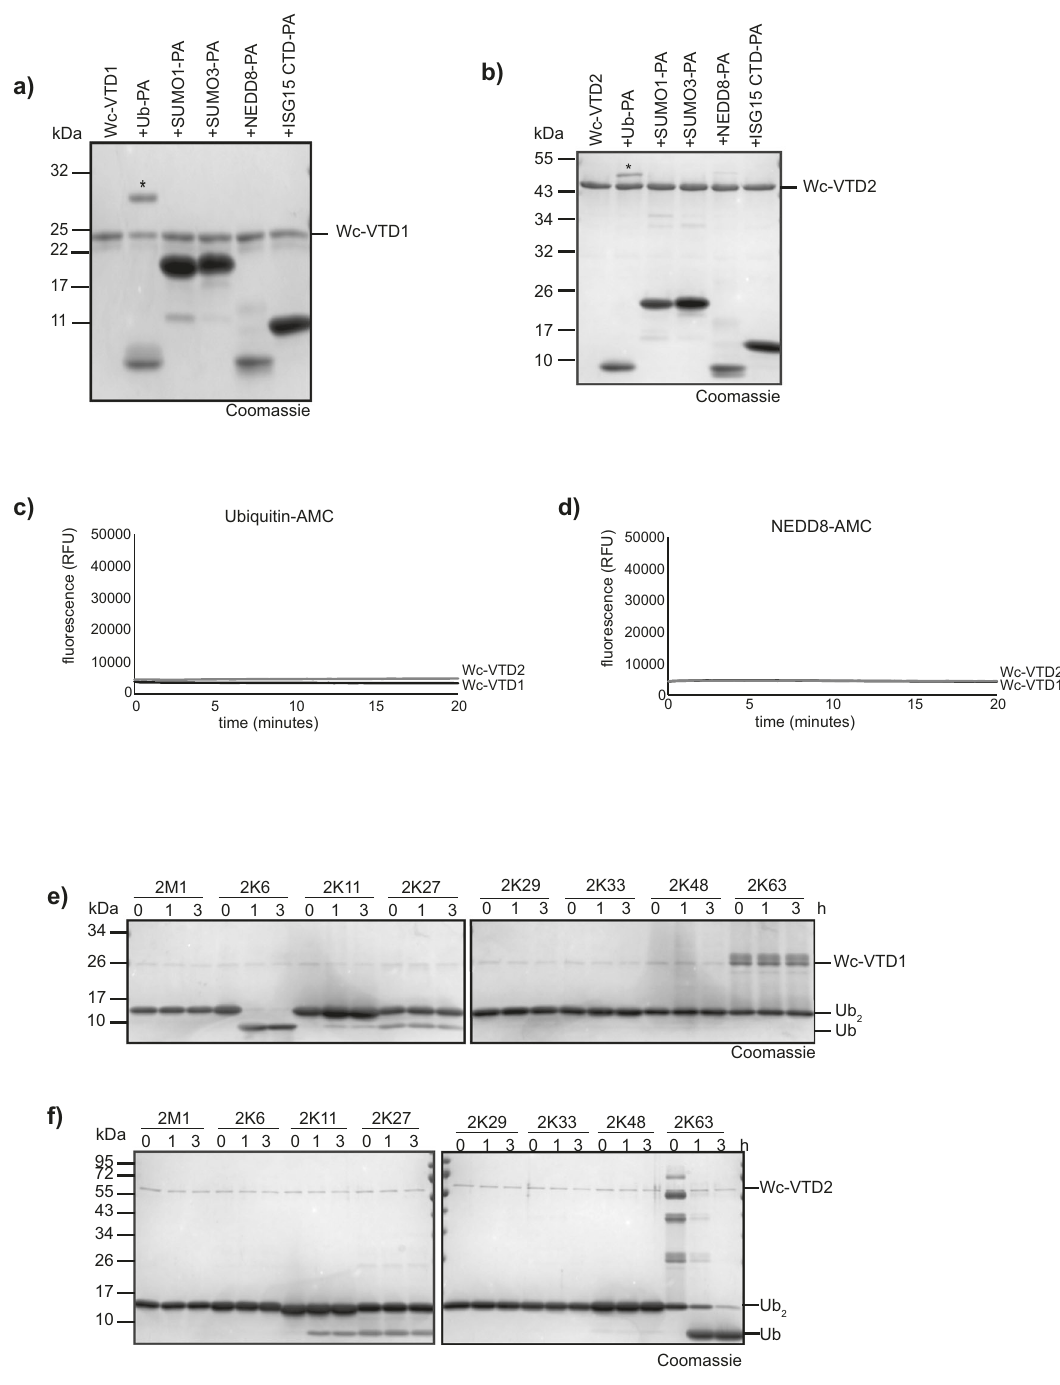
Fig. 4 | Activity of bacterial VTDs. a , b Reaction of Wc-VTD1 ( a ) and Wc-VTD2 ( b ) with Ub and Ubl activity-based probes. Asterisks mark the shifted bands after reaction. c , d Activity of Wc-VTD1 and Wc-VTD2 against Ubiquitin-AMC ( c) and NEDD8-AMC( d ).TheRFUvaluesarethemeansoftriplicates. e , f Linkagespeci fi city